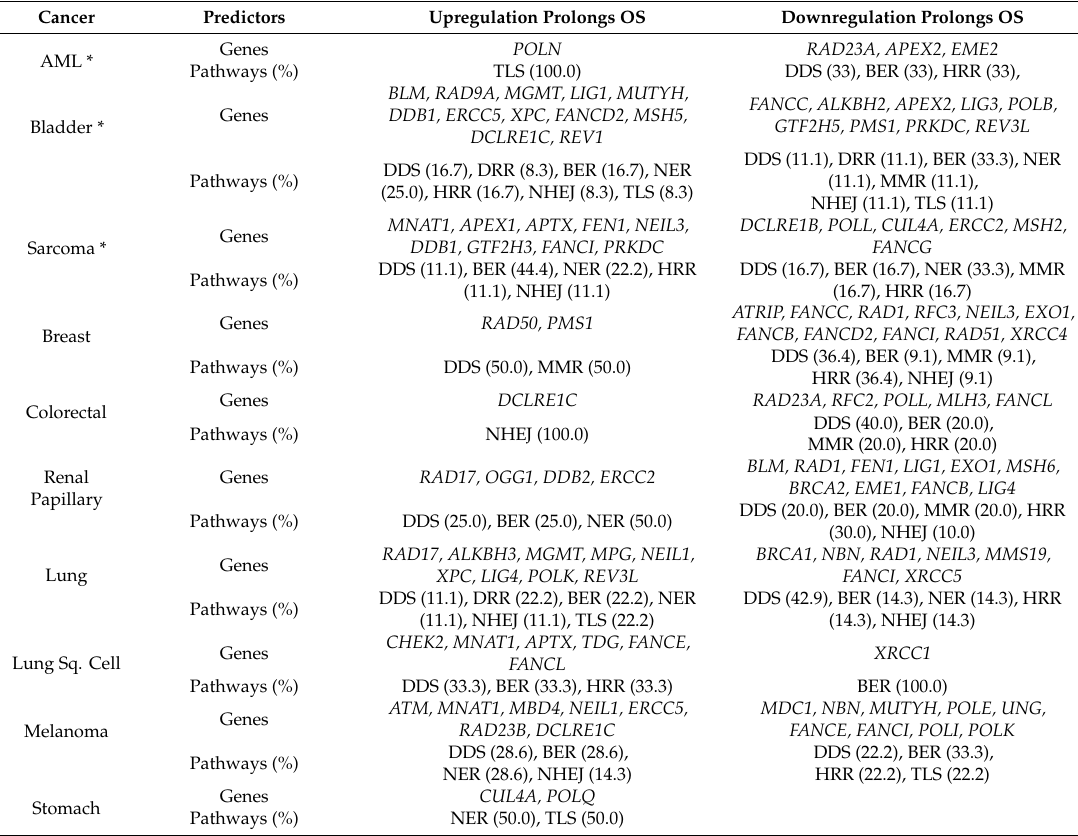
Table 4. Multiple-pathway results showing DNA Repair genes whose upregulation or downregulation prolongs overall survival for subjects with RNA-Seq data in TCGA. Cancers listed had significant empirical p -value test results ( p < 0.05).